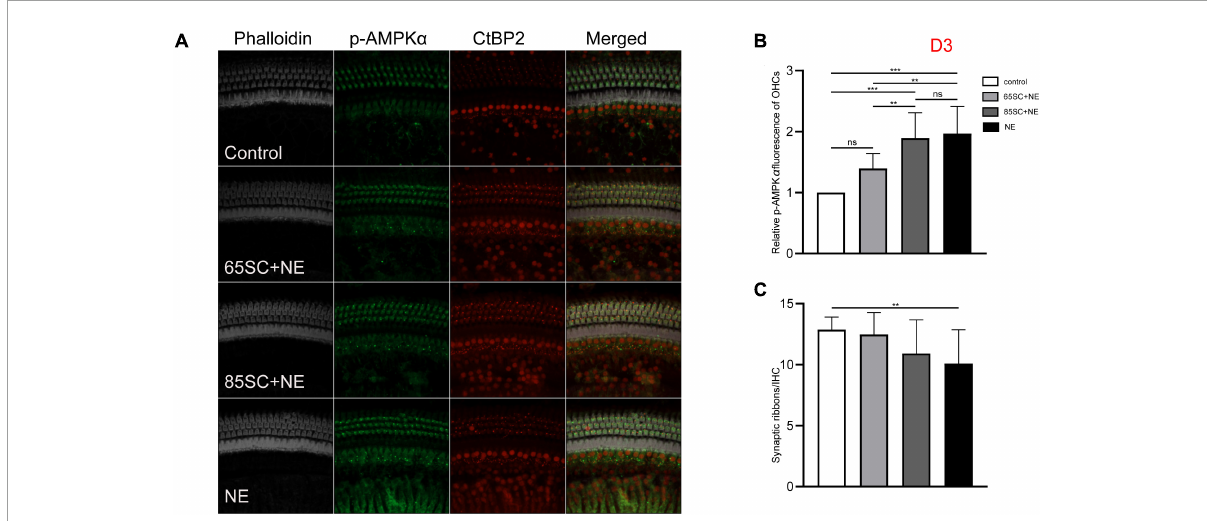
FIGURE6 The p-AMPK α fluorescence intensity and the number of ribbon synapses restored in all groups at D3. (A) The p-AMPK α fluorescence intensity and the number of synapses of the four groups at D3. (B) The p-AMPK α fluorescence intensity in the four groups from the highest to the lowest was in the NE group, 85SC+NE group, 65SC+NE group, and control group. Among them, there was no statistical difference between the 65SC+NE group and the control group ( p > 0.05). (C) The number of synapses in the NE group was lower than the control group ( p < 0.01), and the number of synapses did not differ between the SC+NE groups and the control group ( p > 0.05). ** p < 0.01, *** p < 0.001.